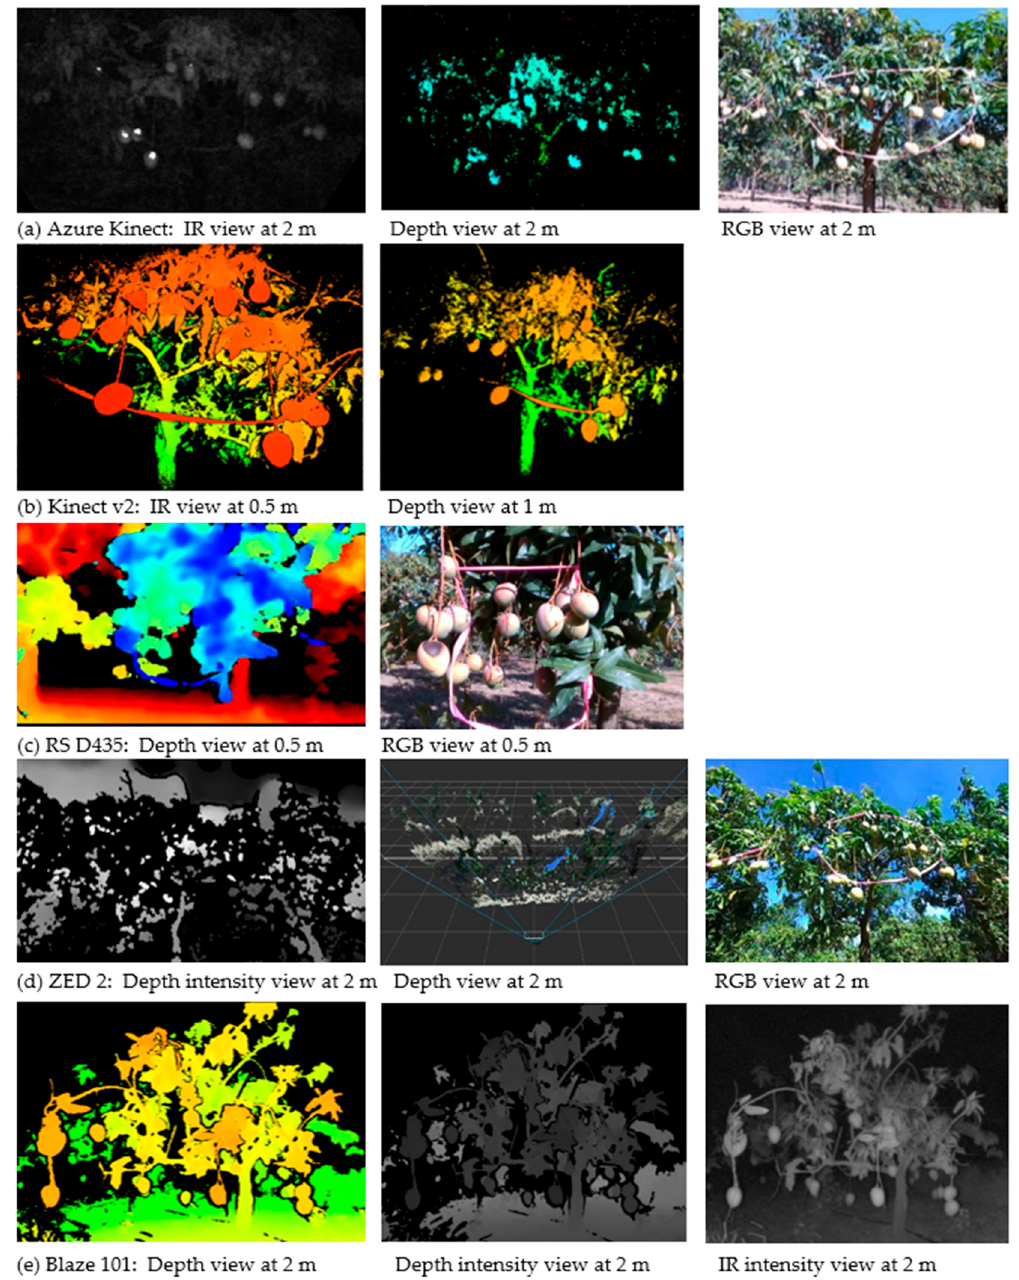
Figure 2. Images of mango trees, with camera-to-the-nearest-fruit distance given in brackets: ( a ) Azure Kinect: IR, depth and RGB images (2.0 m); ( b ) Kinect v2: depth image (0.5 m left, and 1.0 m right); ( c ) RS D435: depth and RGB images (0.5 m); and ( d ) ZED2 depth intensity, depth and RGB images (2 m); ( e ) Blaze 101: Depth image, depth intensity and IR intensity image, from left to right (1.5 m). Five exercises were conducted in evaluation of these depth cameras.